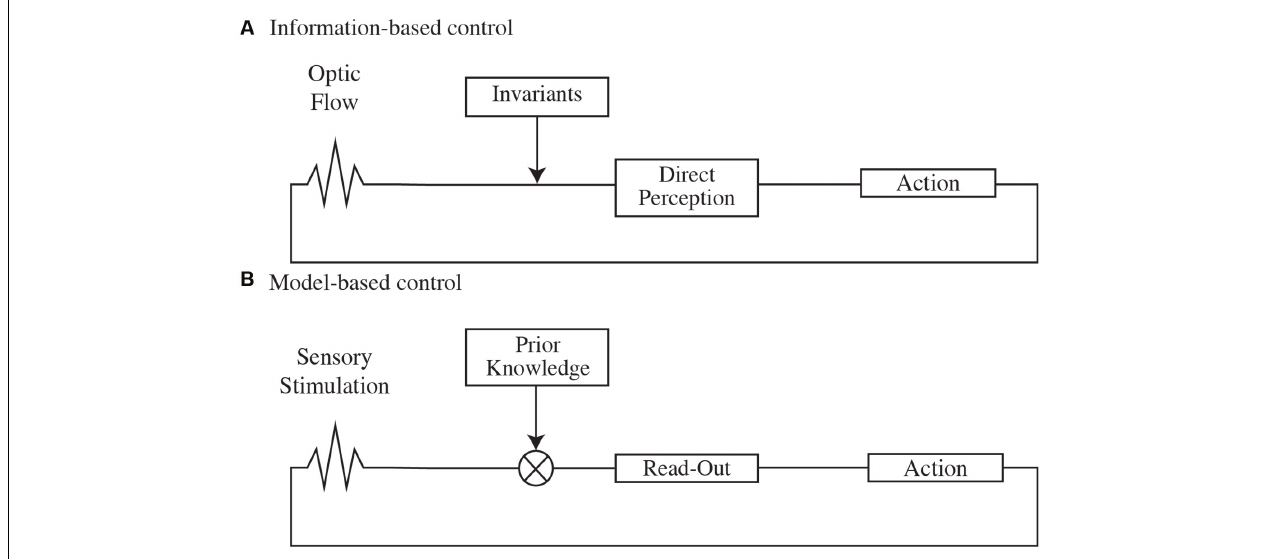
FIGURE 1 | (A) Optic flow conforms to invariants that specify properties of the environment (direct perception), indicating the adequacy and availability of action within the task. (B) Sensory stimulation is combined with prior information to infer current or future states in the environment (read-out), providing the grounds to plan and adapt action.